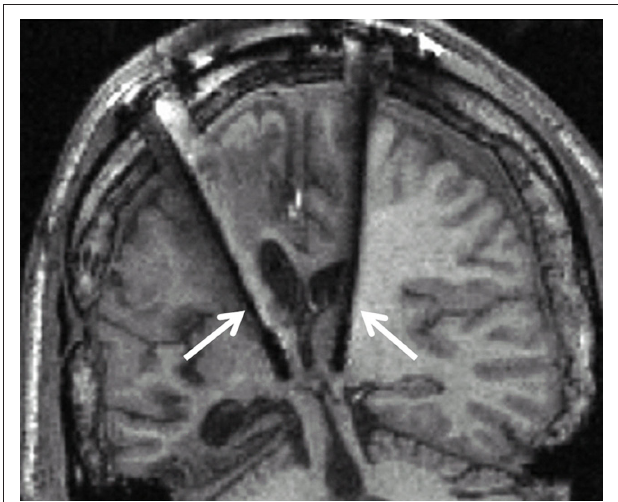
Figure 2 | Clinical setup of electrodes implementation in the central thalami bilaterally (white arrows) during deep brain stimulation. Adapted from Schiff et al.